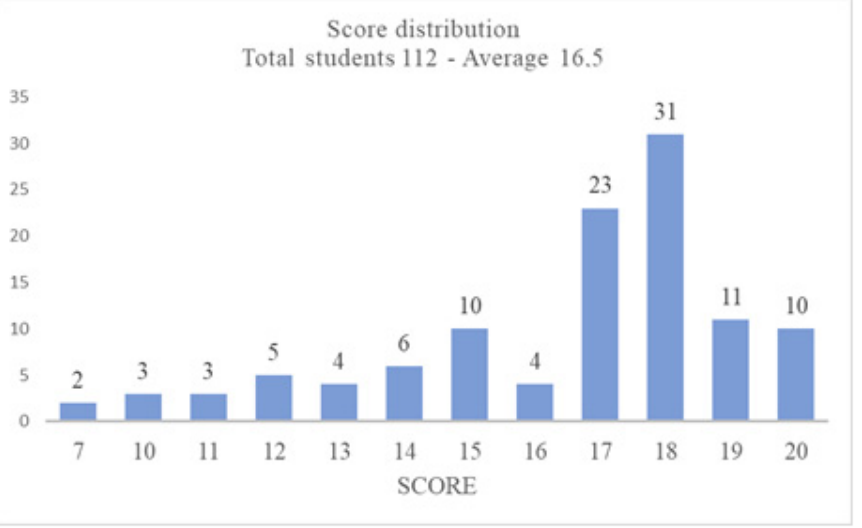
Figure 6. Score distribution of all students who participated in the survey.